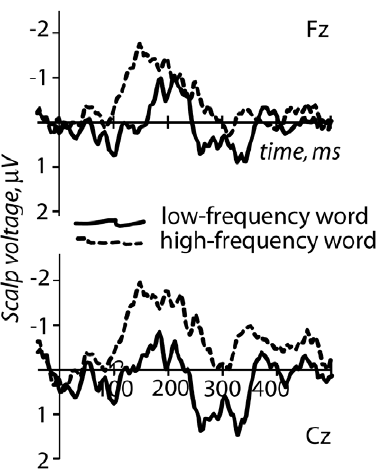
Figure 2. Event-related potentials elicited by standard and deviant stimuli in the high- and low-frequency deviant conditions. Midline channels with maximal ERP amplitudes are shown (superimposed on acoustic stimulus waveforms). Note the more pronounced deviant-standard difference in the high-frequency condi- tion, whereas a smaller difference, which was also more focal (here confined to Fz), emerged in the low-frequency condition.